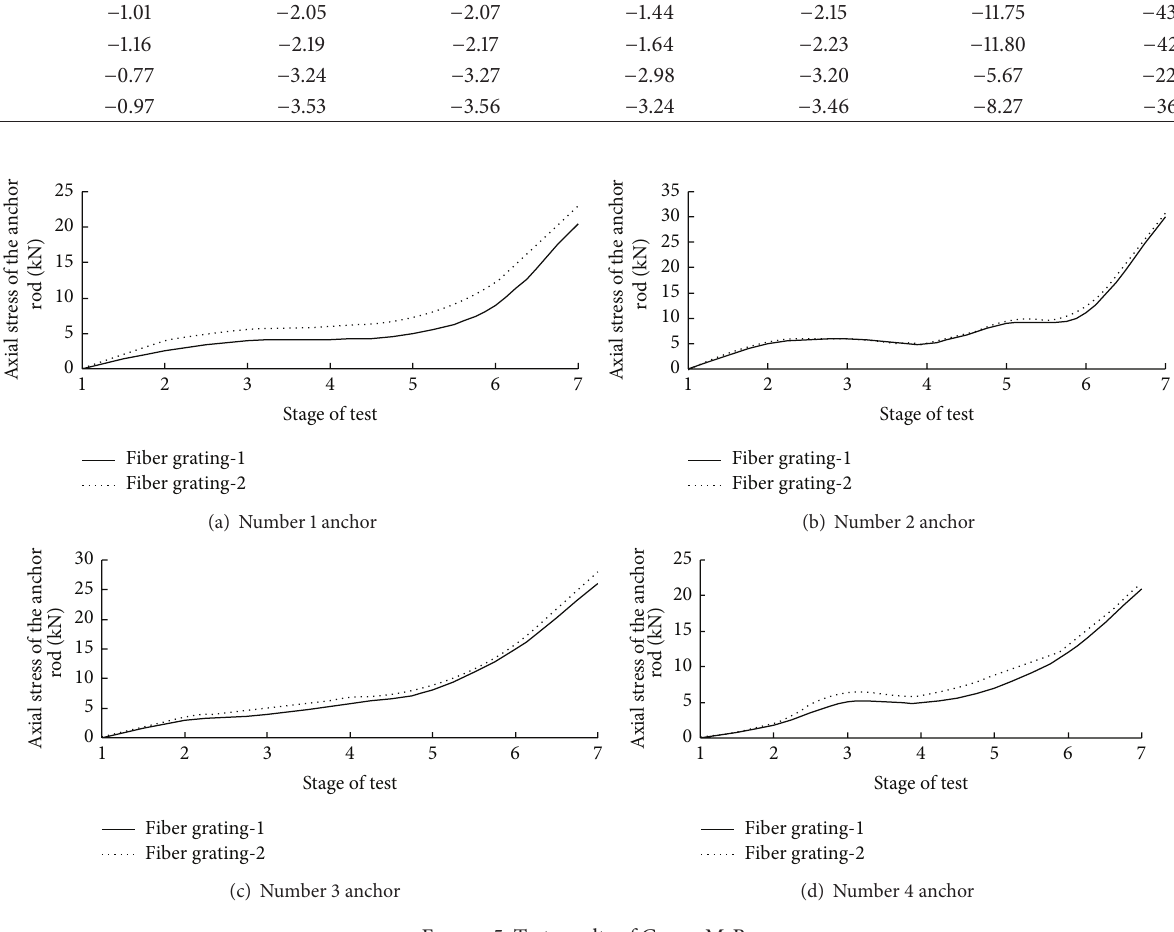
Figure 5: Test results of Group